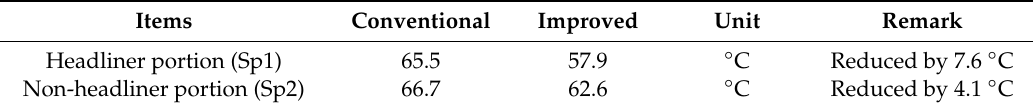
Figure 19. Surface temperature of headliner upon leaving vehicle outdoors in summer (thermal camera measurements): ( a ) Conventional; ( b ) Improved. Table 4. Comparison of surface temperature.